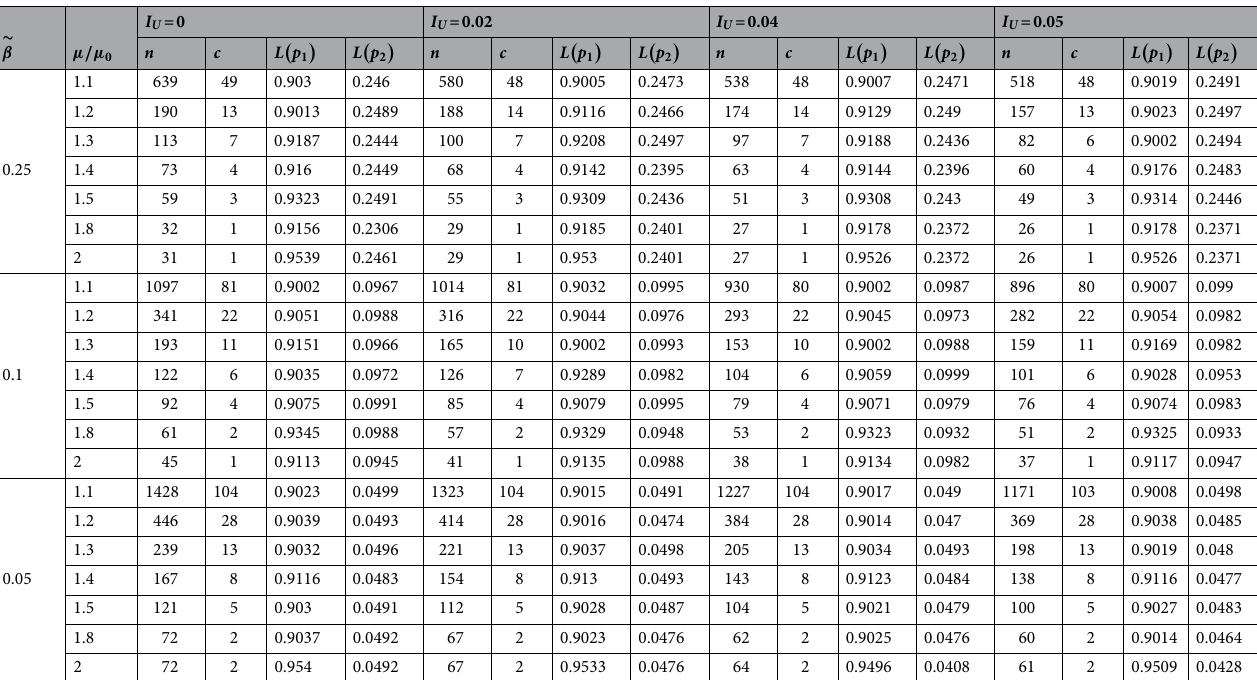
∼ α = 0.10 ; β = 3 and a = 0.50